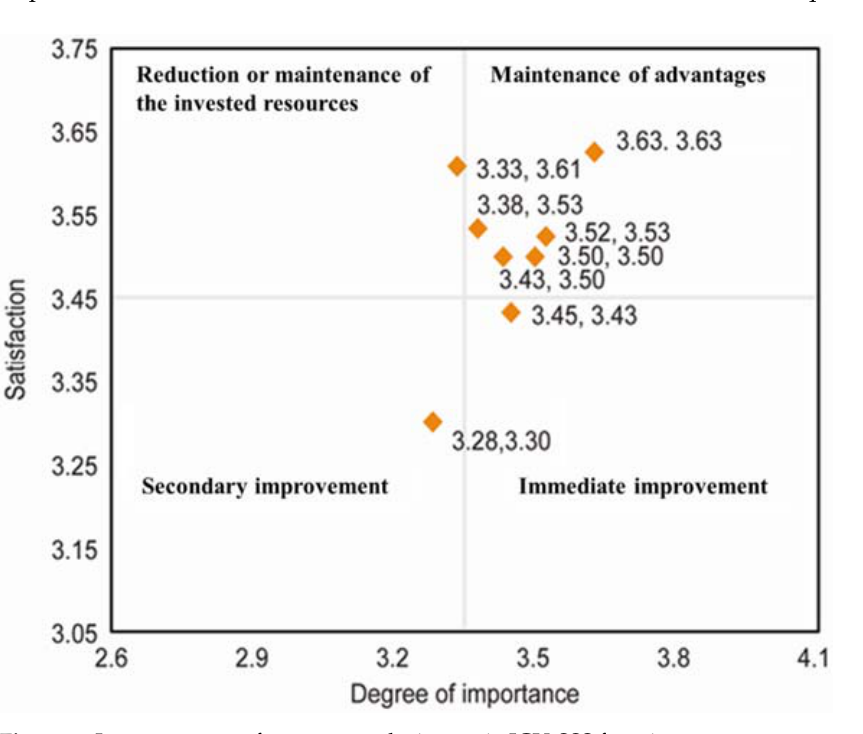
Figure 3. Importance–performance analysis matrix ICU-SSS